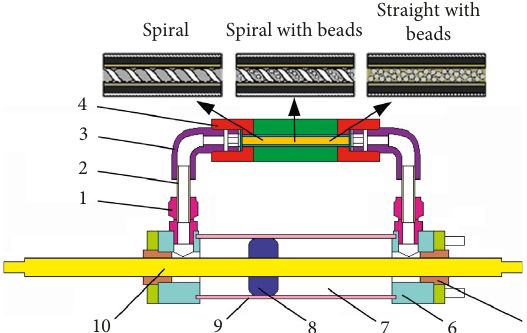
Figure 22: Bypass-type MR damper with external coil: 1, tube fitting adapter; 2, stainless steel tubing; 3, tube fitting elbow; 4, bypass; 5, seal; 6, end block; 7, MR fluid; 8, piston head; 9, piston casing; 10, damper shaft